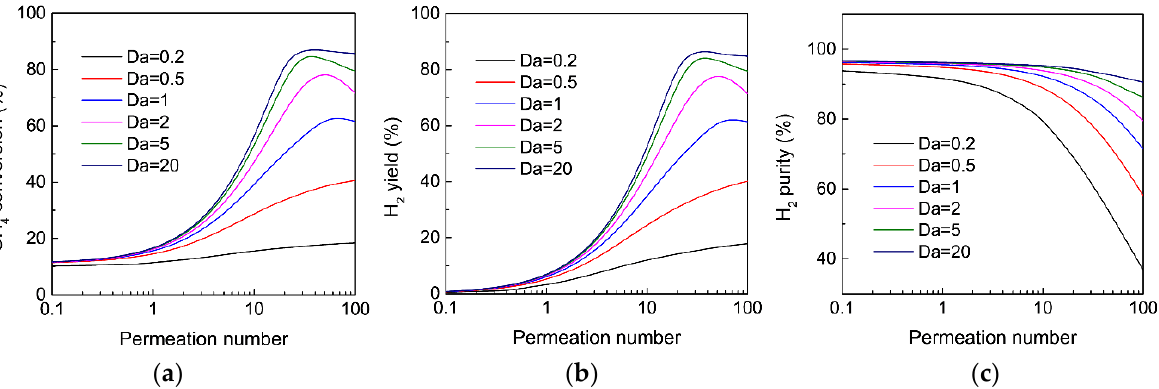
Figure 4. Effect of the Damköhler number on ( a ) CH 4 conversion, ( b ) H 2 yield, and ( c ) H 2 purity as a function of permeation number for MDA in the MR. (Simulation conditions: T = 973 K, α H α CH = Knudsen selectivity, p h = 1 bar, p l = 0.05 200, 4 / C 6 H 6